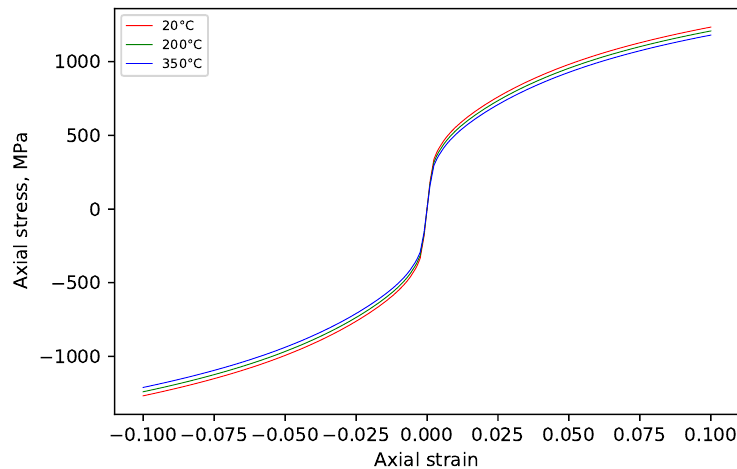
Figure 11. Stress–strain curve for metal